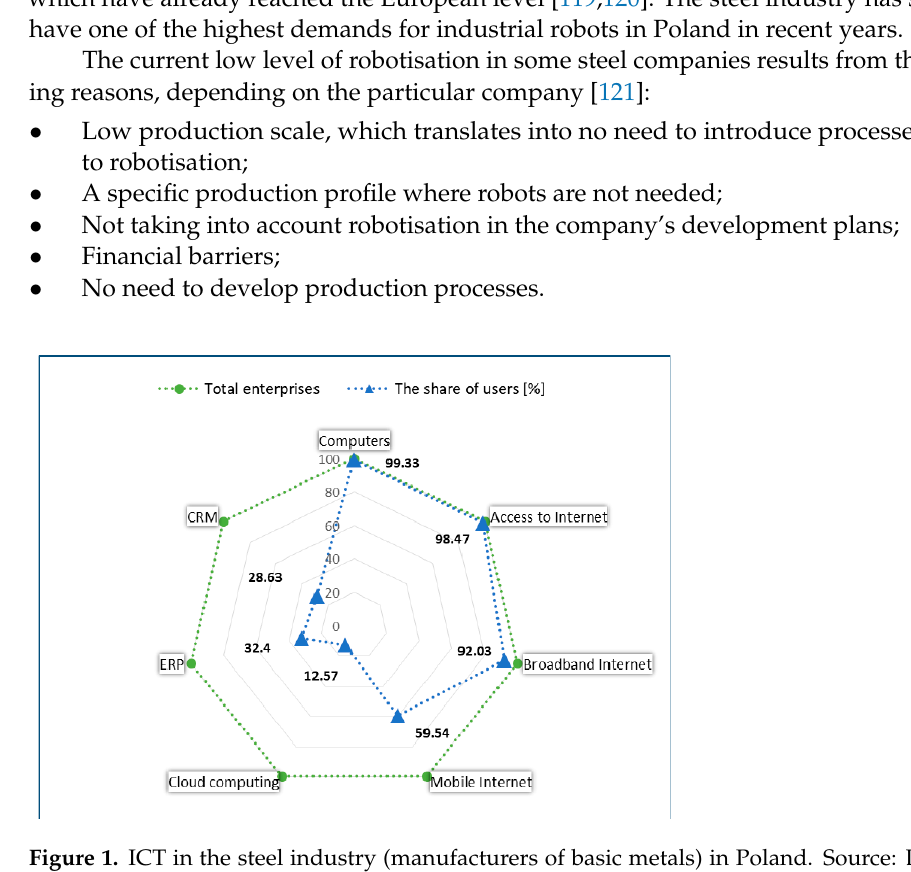
Figure 2. ICT and labour productivity in the steel industry (manufacturers of basic metals) in Poland. Source: Data from GUS [122].